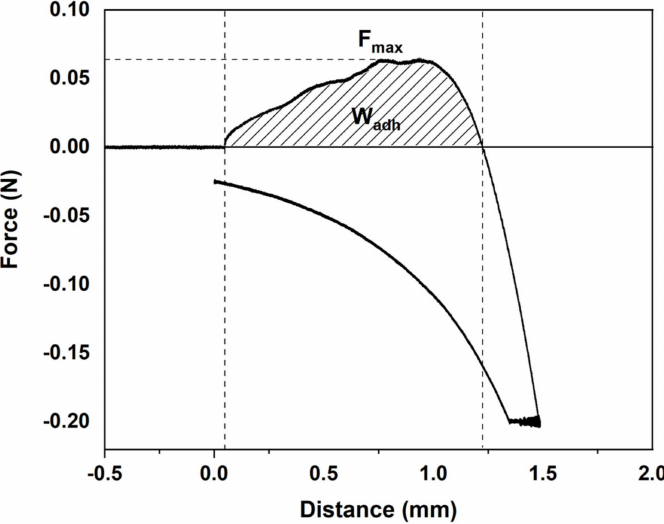
Figure 10. Characteristic load versus deformation curve for THC6 scaffolds.